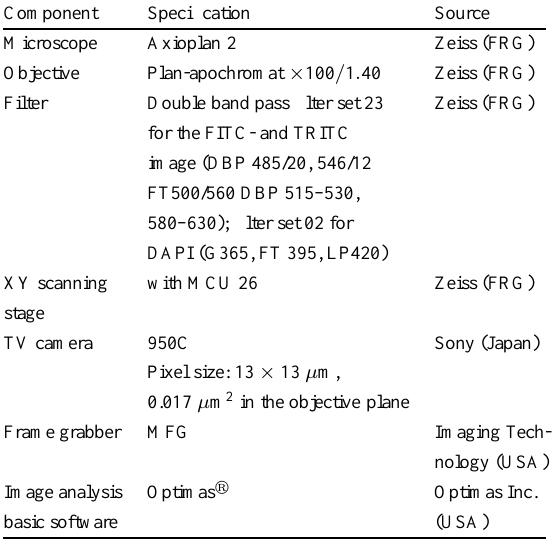
Technical equipment of the image cytometry workstation for acqui- sition of fluorescence images